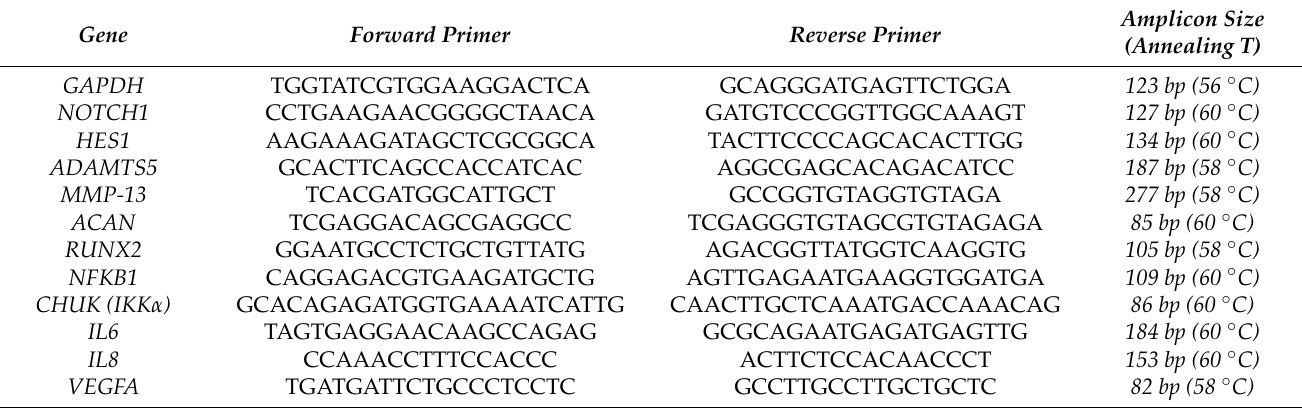
Table 1. List of primers used for real time